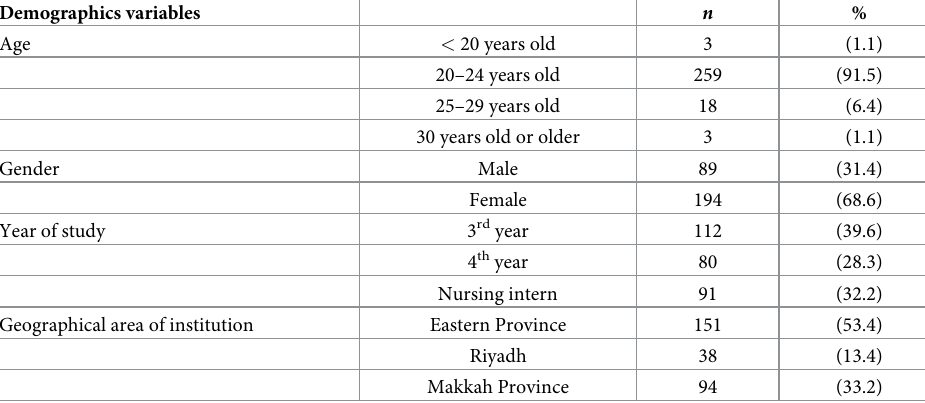
Table 1. Demographics characteristics of the